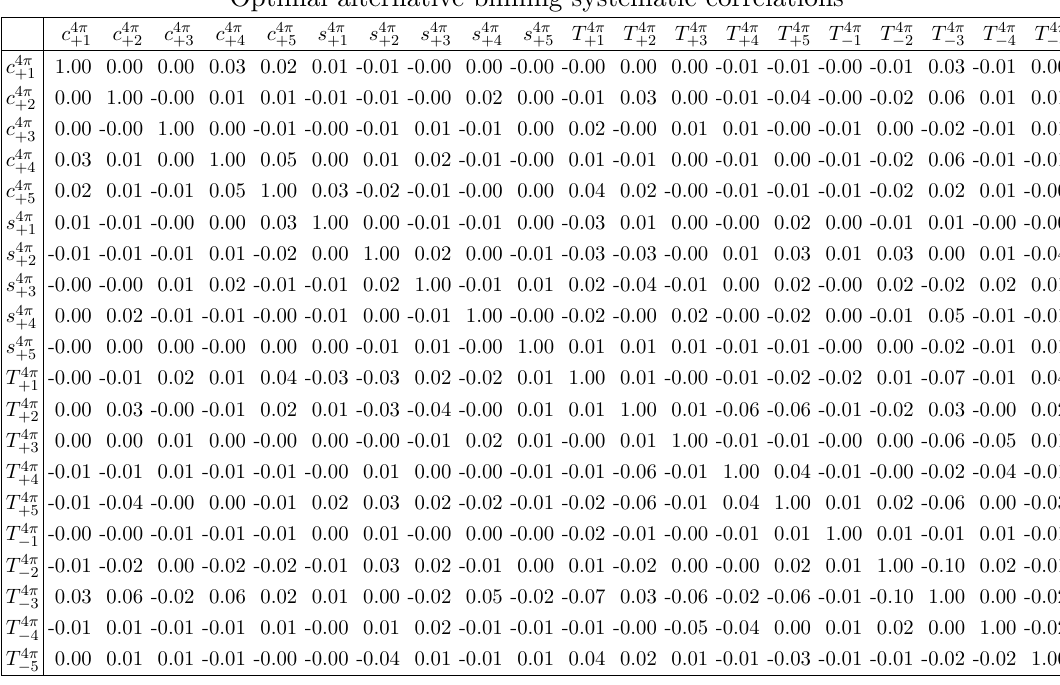
Table 13 . The statistical and systematic correlations between the 4 (cid:25) (cid:6) hadronic parameters using the Optimal alternative binning scheme with N =